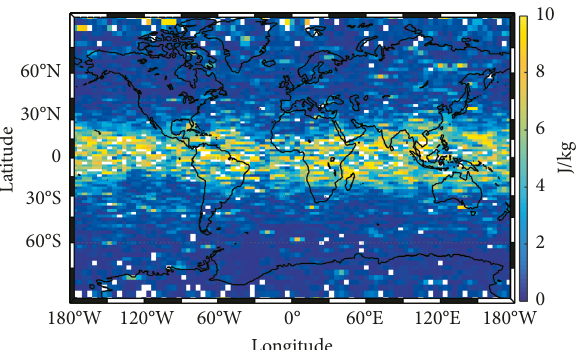
Figure 12: Global distribution of gravity wave potential energy from FY-3C occultation data at the height of 20–30km in northern hemisphere winter from 2015 to